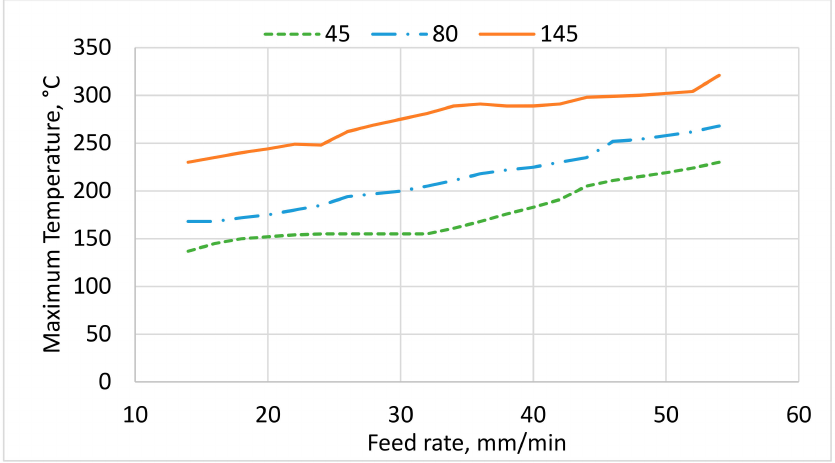
Figure 8. Simulation results for maximum temperature with changing feed rates at the defined cutting speeds (45, 80, 145 rpm) in drilling of AISI 1018